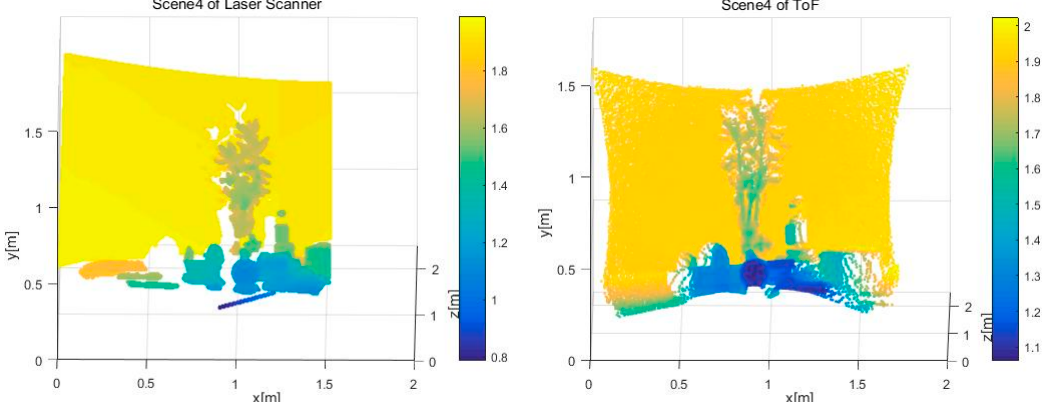
Figure 11. Depth images based on the point cloud of depth sensors.